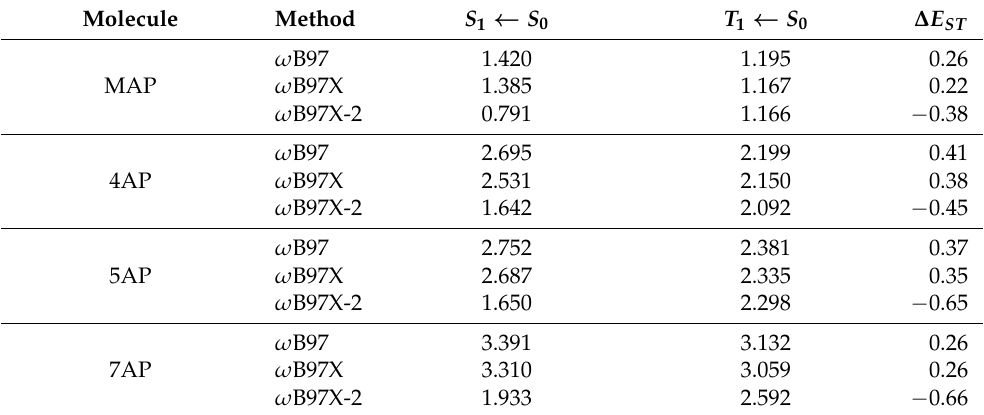
Table 1. Vertical excitation energies and associated ∆ E ST energy difference (all in eV) calculated with different methods.